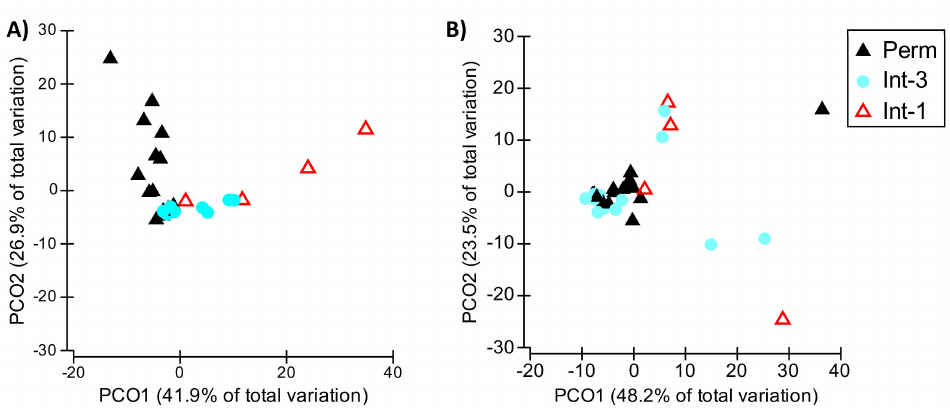
Figure 3. Principal Coordinates Analysis (PCoA), for significant Permutational Analysis of Variance (PERMANOVA) models. ( A ), stygoxenes; ( B ) stygophiles. Station codes as in Figure